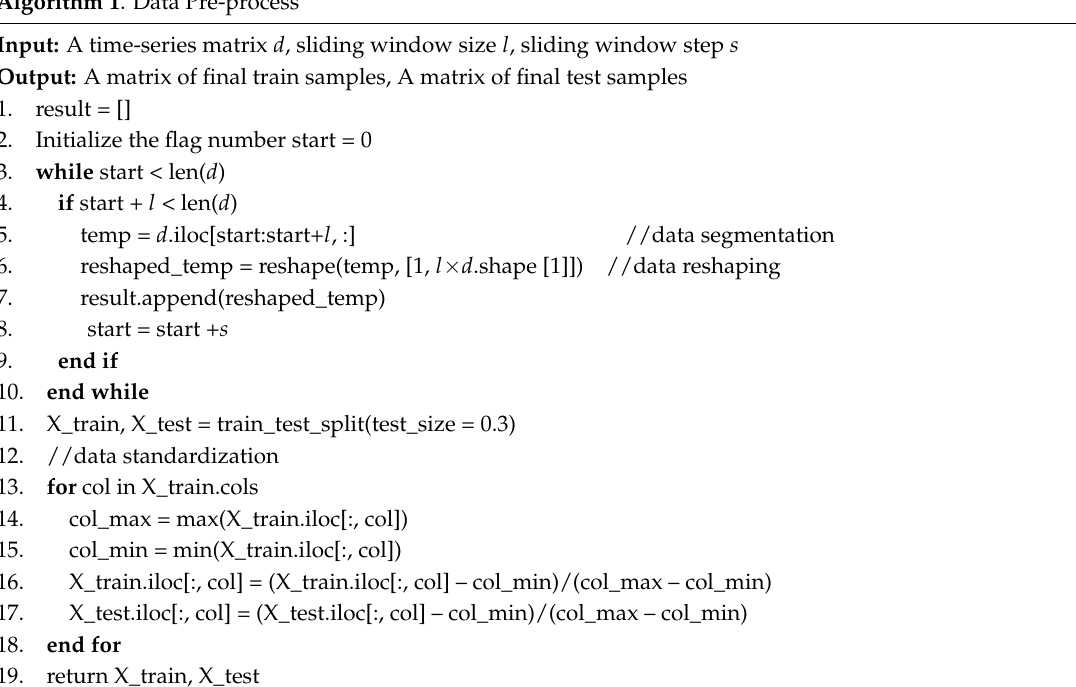
Algorithm 1 . Data